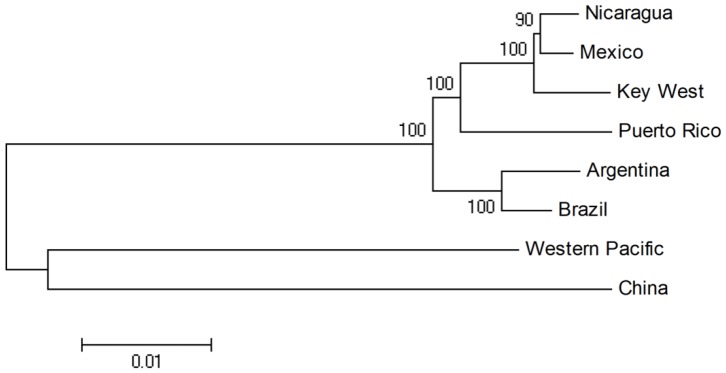
Phylogenetic tree of DENV-1 genome sequences from different geographic regions.This indicates Key West and Nicaragua as offspring strains of Puerto Rico.